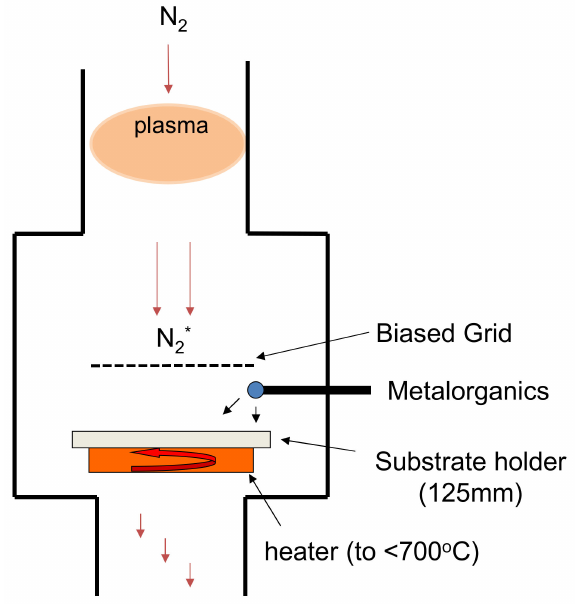
Figure 1. Schematic diagram of the plasma system used for GaN film deposition. The substrate is located 125 mm away from the plasma source; the grid is 40 mm above the substrate.